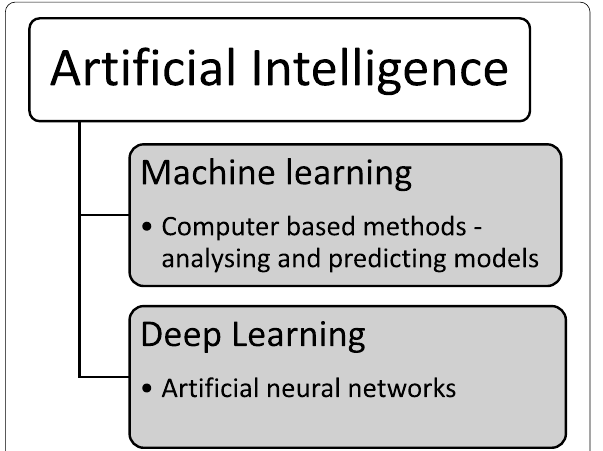
Fig. 1 Bifurcation of artificial intelligence into two main types— machine learning and its subset, deep learning